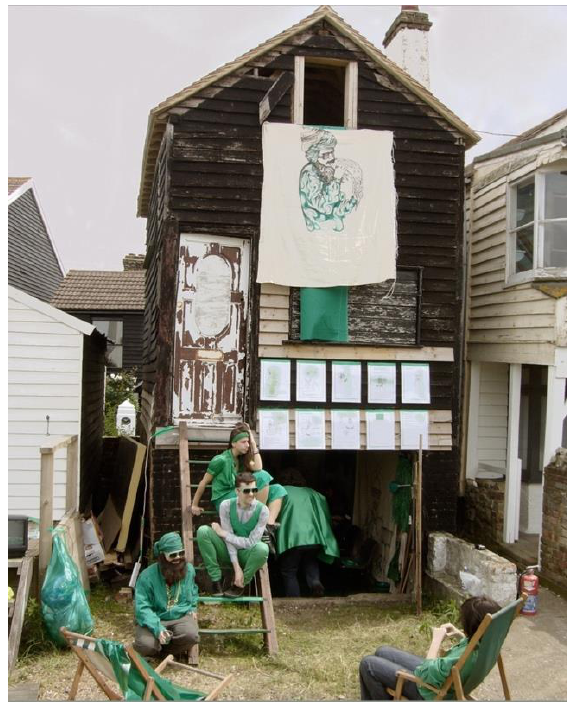
Figure 17. Oreet Ashery, The Saints of Whitstable , 2008, two-week performance, Whitstable Biennale. In the image: Oreet Ashery, Terence McCormack, Magdalena Suranayi, and Laura Hensser sitting outside the hut before performing the play reading. Photo credit unknown.